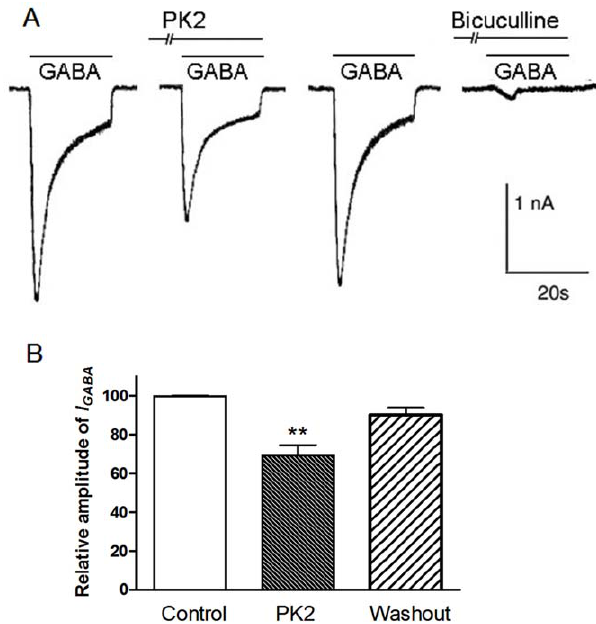
Figure 4. Inhibition effect of PK2 on exogenous GABA-induced currents in SCN neurons. (A) The inward currents were elicited by 0.1 mM GABA in a SCN neuron voltage clamped at 2 70 mV. PK2 exerted an inhibitory effect on the GABA-activated current. PK2 (0.1 nM) was pre-applied to external solution for 10 min. The GABA-activated current could be blocked by 30 m M bicuculline. (B) A summary bar graph showing PK2 had significant effect on the responses to exogenous application of GABA (*P , 0.05, n=7).